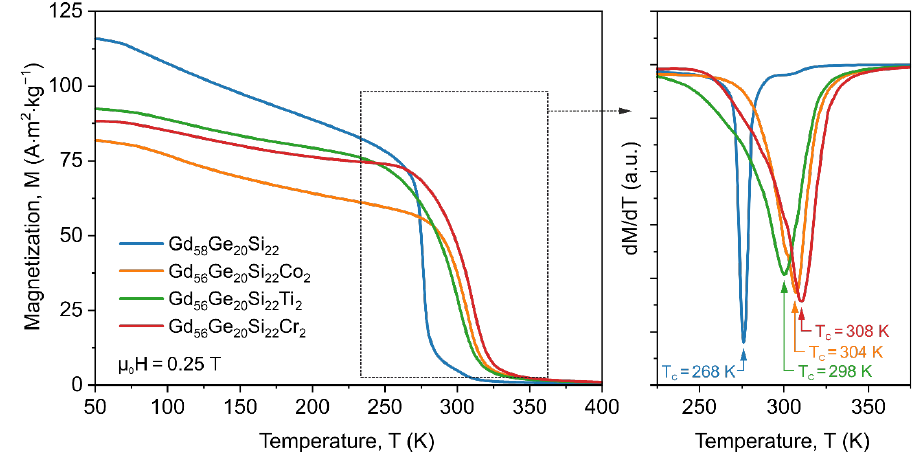
Figure 3. Magnetic magnetization versus temperature curves for the Gd 58 Ge 20 Si 22 , Gd 56 Ge 20 Si 22 Co 2 , Gd 56 Ge 20 Si 22 Ti 2 and Gd 56 Ge 20 Si 22 Cr 2 alloys annealed at 1450 K for 2 h recorded at external DC magnetic field of 0.25 T.